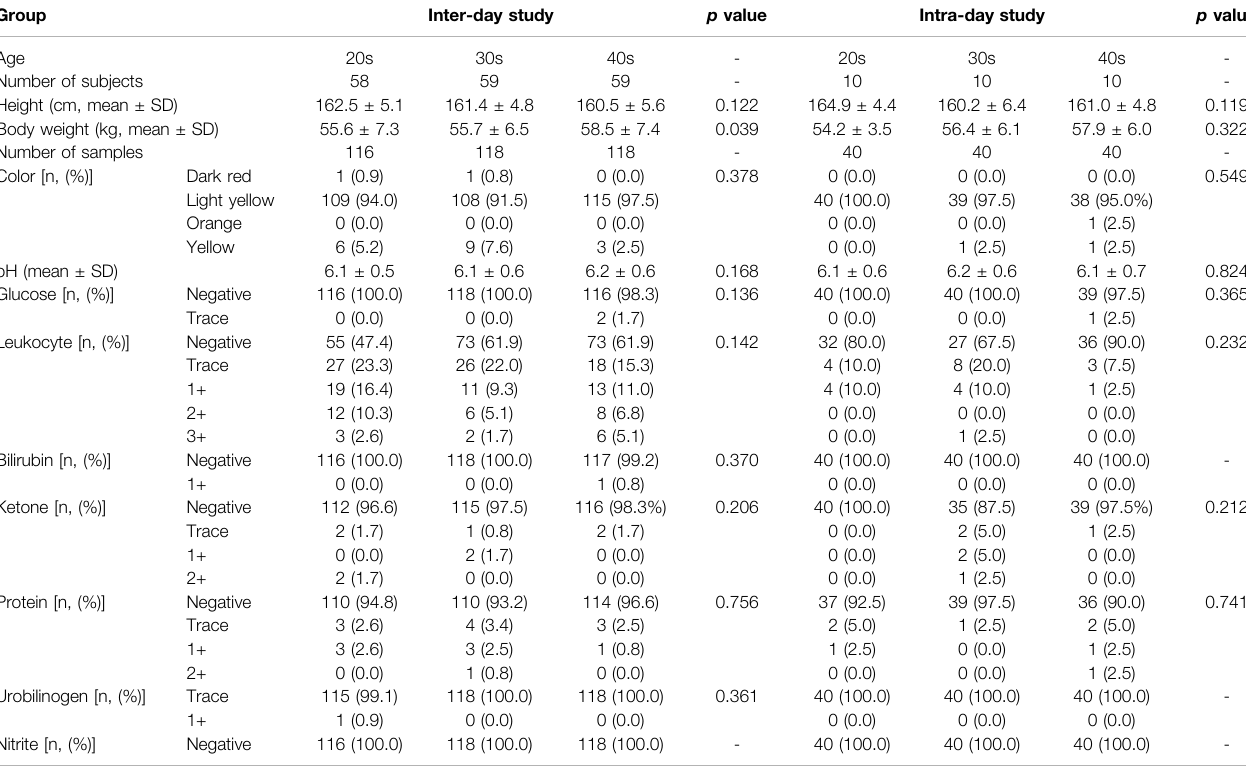
TABLE 1 | Demographics and clinical urinalysis of subjects according to age groups in the inter- and intra-day studies. Group Inter-day